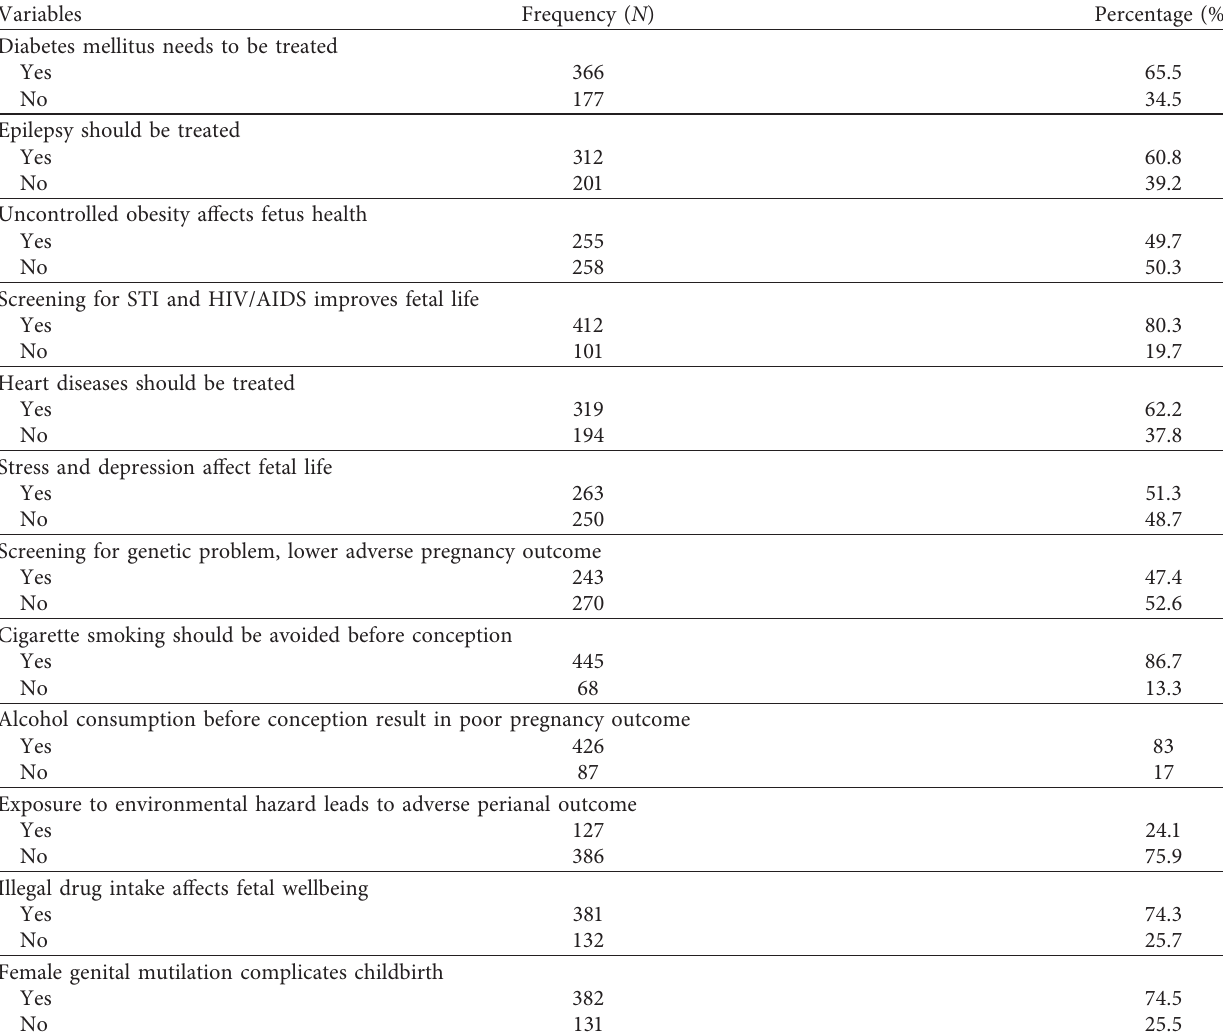
Table 3: Women’s knowledge of preconception health-related behavioural risk factors on the fetus in Jinka town, Southern Ethiopia, 2018 ( n �